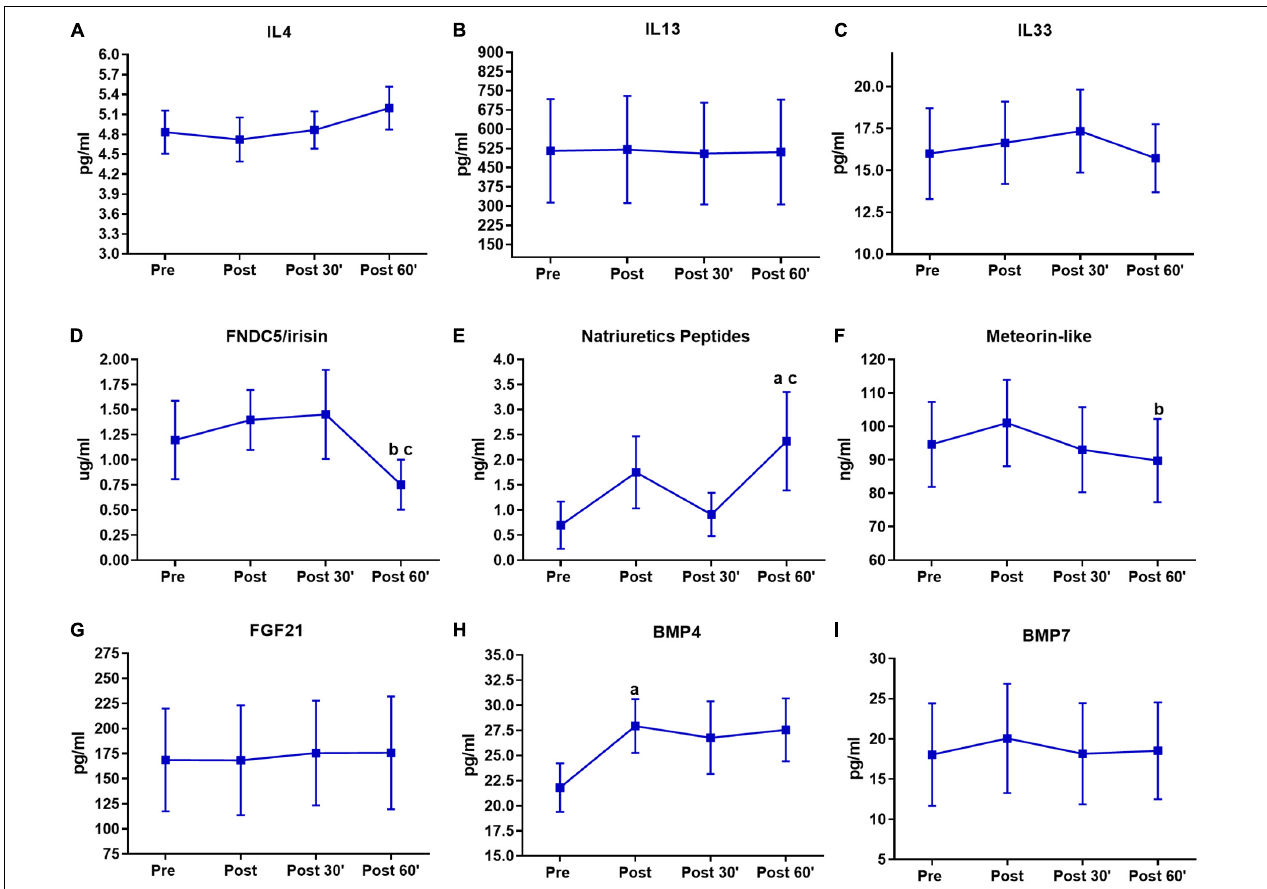
FIGURE 4 | Serum pro-thermogenic/anti-inflammatory inductors time-course in the last training session. (A) IL4. (B) IL 13. (C) IL33. (D) FNDC5/irisin. (E) Natriuretic peptides. (F) Meteorin-like. (G) FGF21. (H) BMP4. (I) BMP7. a P < 0.05, difference from the moment pre. b P < 0.05, difference form the moment post. c P < 0.05, difference from the moment 30 (cid:48) . n = 15 per group, except FNDC5/irisin n = 8; and natriuretic peptides n = 12, both in feeding group. Values are in mean ± standard error.